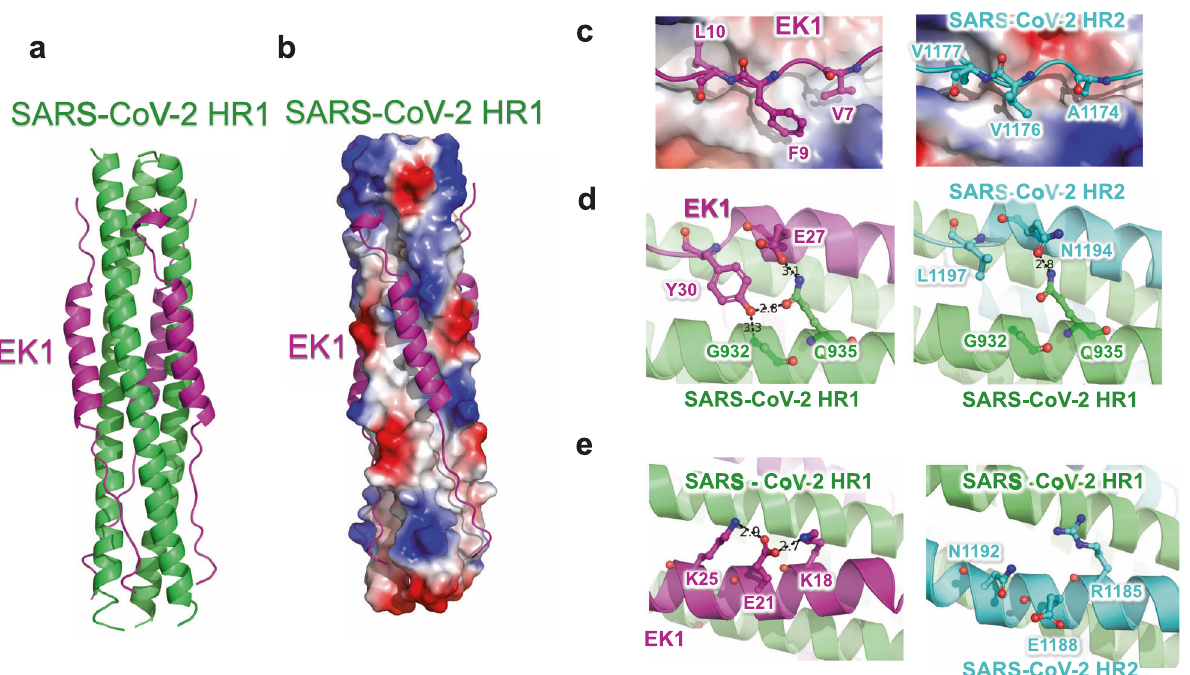
Fig. 4 Crystal structure of 6-HB formed by SARS-CoV-2-HR1 and EK1. a The structure of SARS-CoV-2-HR1 and EK1 is shown in cartoon representation with HR1 colored in green and EK1 in magenta. b HR1-trimer of SARS-CoV-2 is shown in electrostatic surface, and EK1 is shown in cartoon representation. c – e Interactions of SARS-CoV-2 HR1 motif against EK1 peptide and SARS-CoV-2 HR2 motif. Important binding residues are shown in sticks and (Supplementary Table S1). In this structure, EK1 fi ts into the groove formed between two adjacent HR1 helices in antiparallel manner, resulting in a 6-HB structural mimic as tightly assembled as that of the viral trimer HR1-HR2 complex in post-fusion state (Fig. 4a). 9